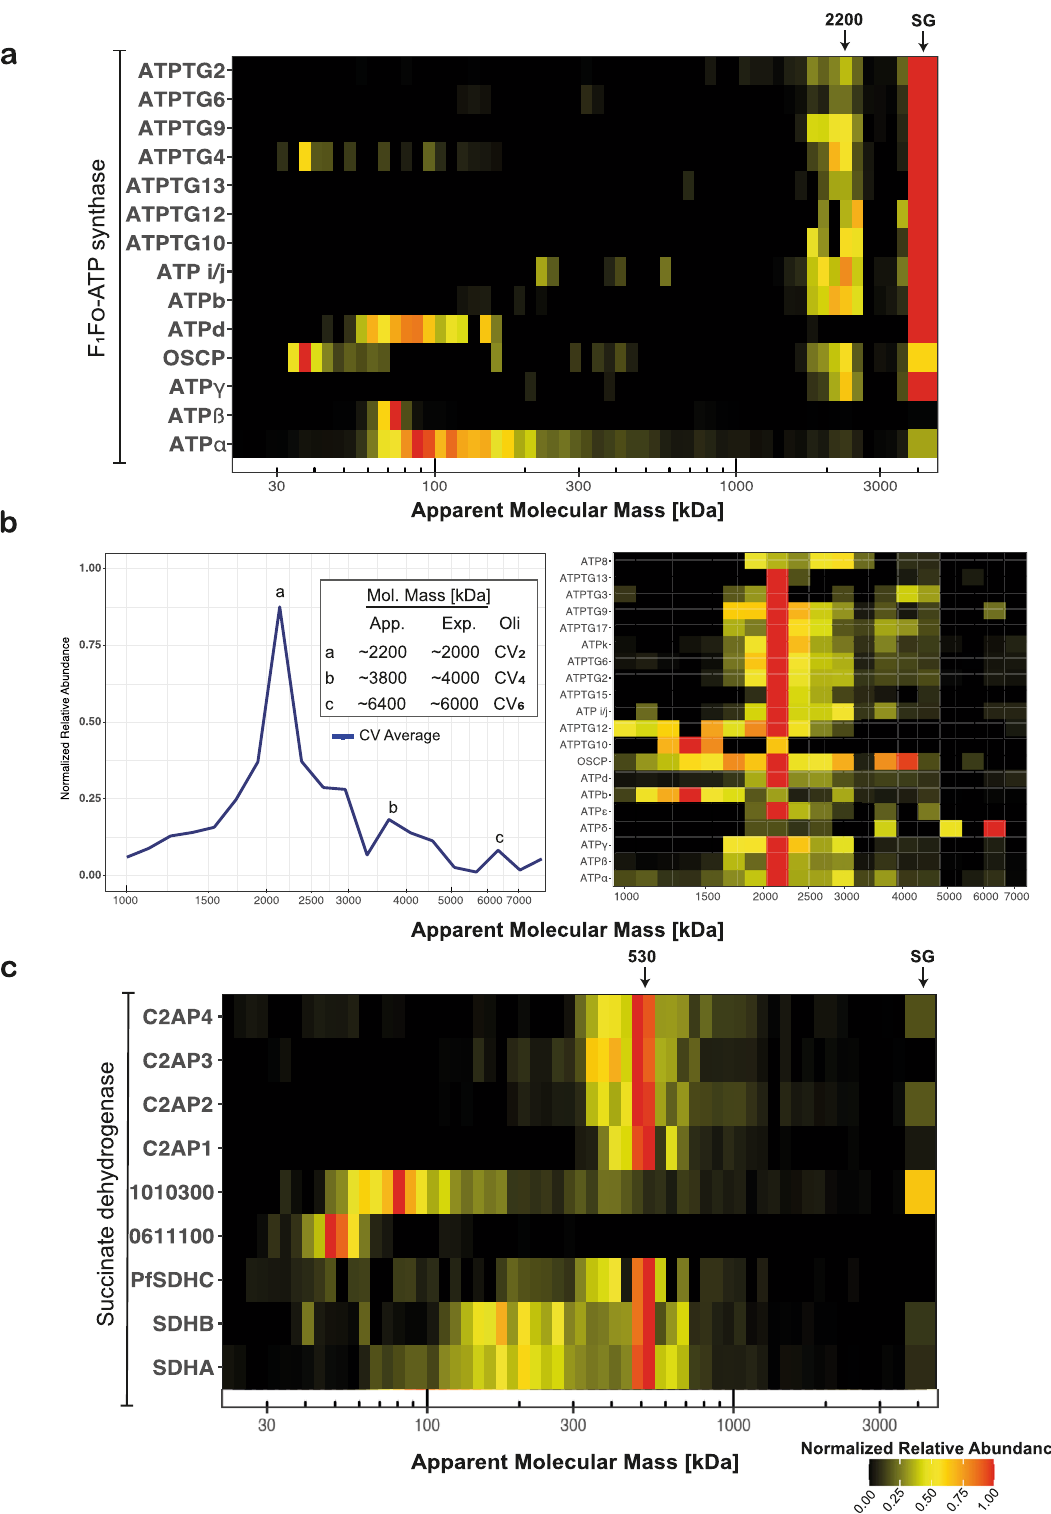
Fig. 5 Composition and apparent molecular mass of succinate dehydrogenase (CII) and ATP synthase (CV) in Plasmodium falciparum gametocytes. a Heatmap showing migration patterns of canonical ATP synthase components as well as components identi fi ed in T. gondii in sample GCT3D 59 . Most components show comigration at a size band from 2 – 3 MDa as well as abundance in the stacking gel interface (rightmost slice). ATPd, ATP β , OSCP and ATP α appear to be most abundant at their respective monomeric sizes. b Heatmap and lineplot showing migration pattern of putative ATP synthase components in 3-16% MDa pro fi les. Inlet of lineplot describes putatively assigned di- (a), tetra- (b), and hexamer (c) states. c Heatmap showing SDHA and SDHB comigrating at an M r app. of ~530 kDa along with a group of putative novel components. Previously assigned proteins (PF3D7_1010300 and PF3D7_0611100 67 ) were not found to be comigrating. Stacking gel (SG) is represented broader in the heatmap and indicated with a black